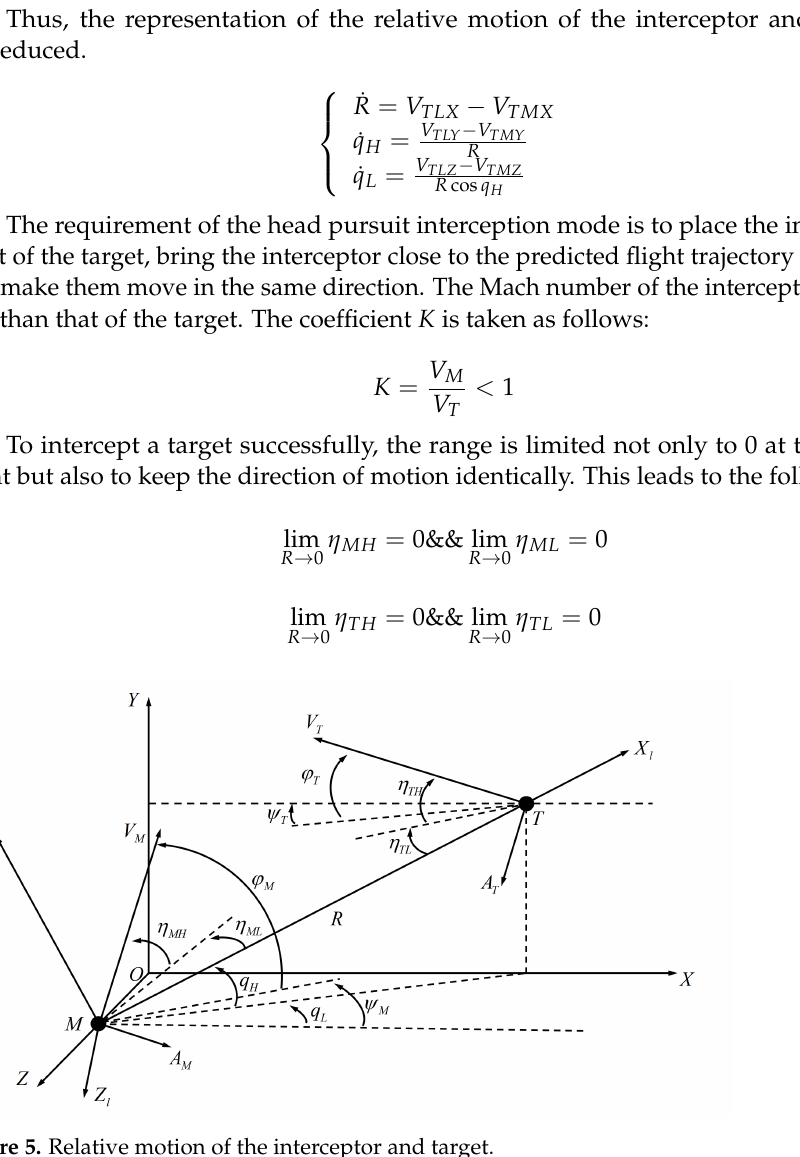
Figure 5. Relative motion of the interceptor and